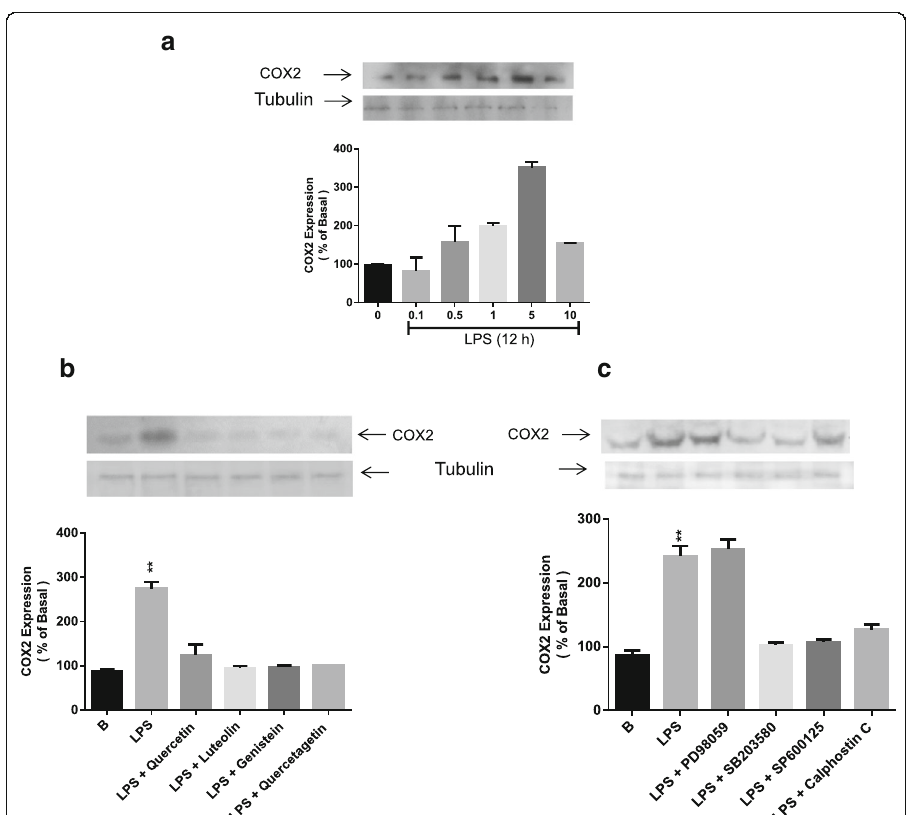
Fig. 6 Effect of LPS and flavonoids on COX-2 expression. a – H9c2 cells were incubated with LPS at different doses. b – H9c2 cells were pretreated with flavonoids (10 μ M) for 1 h and then incubated with LPS (1 μ